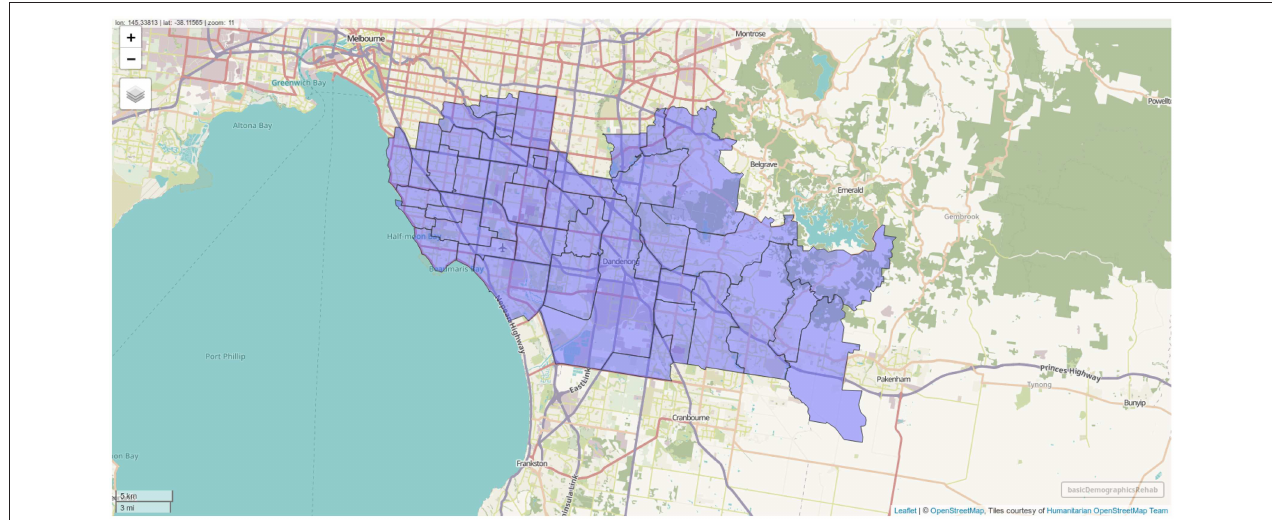
FIGURE 5 | Boundaries of postcodes with centroids within 10 km of one of the rehabilitation centers. Screenshot of interactive visualization created with mapview .